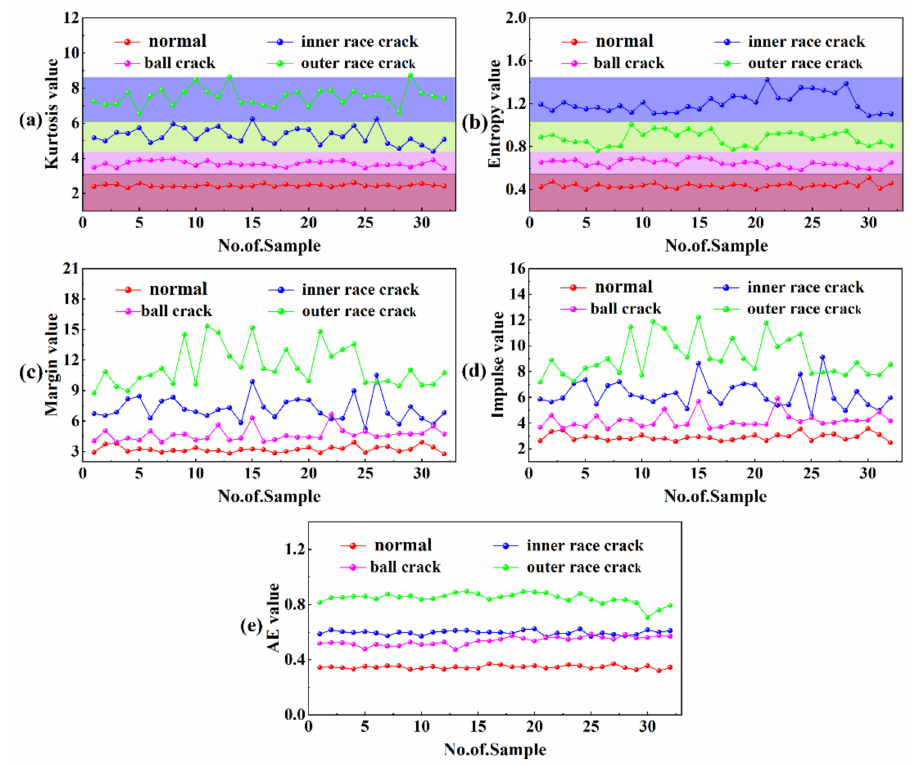
Figure 7. Feature distribution diagram of IMS bearing under various working conditions: ( a ) Sample entropy value, ( b ) Kurtosis value, ( c ) Margin value, ( d ) Impulse value, ( e ) AE value.